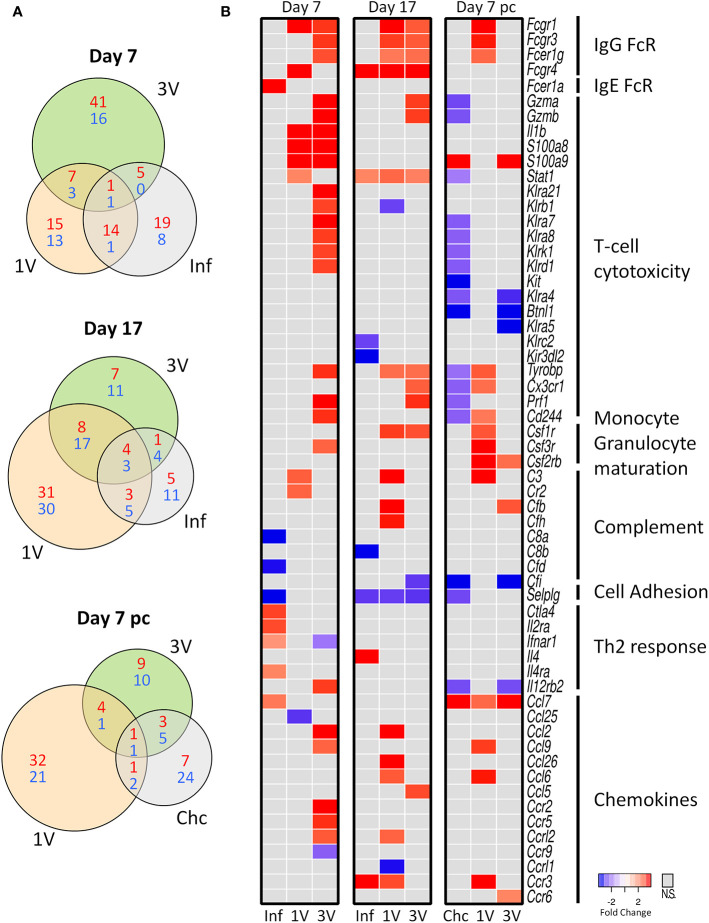
Evaluation of gene expression in PBMC by Nanostring method. (A) The shared and unique elements of PBMC by Nanostring analysis showing the DEGs of Inf, 1V and 3V groups at Days 7 and 17 after immunization and Day 7 post-challenge represented in a Venn Diagram (red: up regulated, blue: down regulated) (FDR not adjusted, p < 0.05). (B) Heatmaps showing gene expression of a list of 51 differentially expressed genes (DEGs) relative to control PBMC. Data derived from longitudinal assay➀ (nine mice per group). Three biological replicates were assessed per group per time point, in which each individual biological replicate consisted of a pool of PBMCs from three mice (
Supplementary Table 1
).